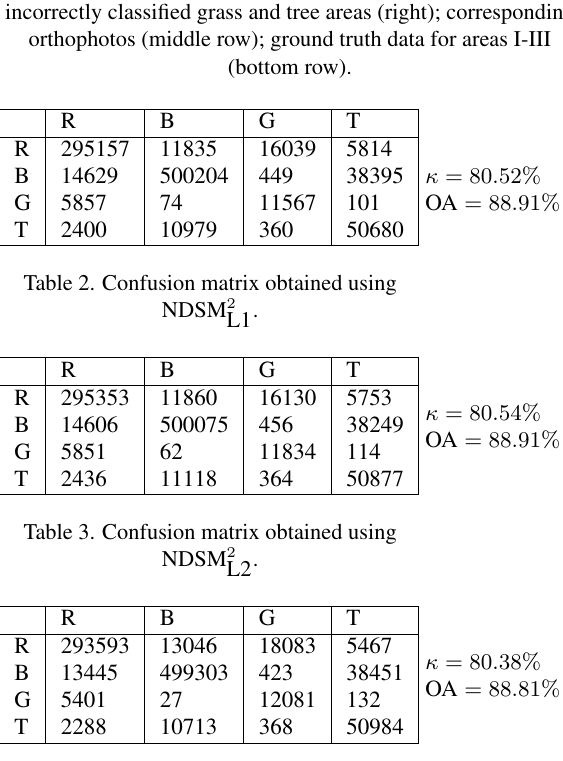
Table 4. Confusion Matrix obtained